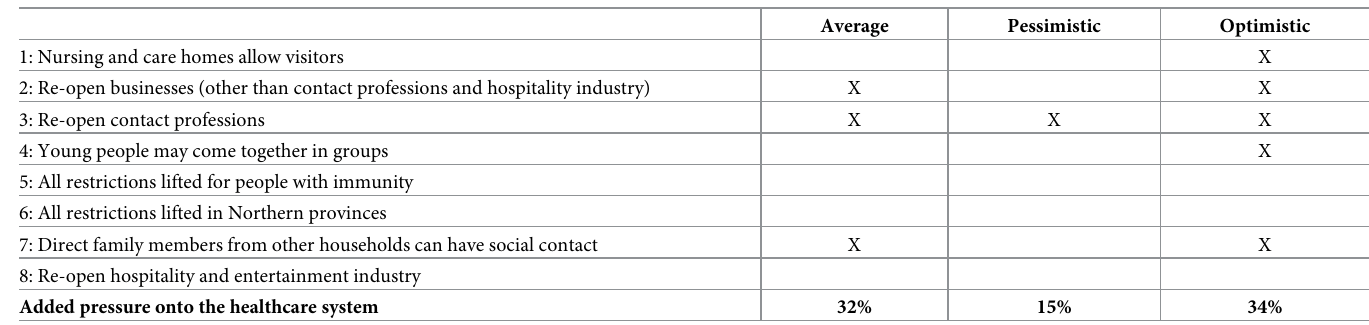
Table 4. Optimal portfolios of relaxation